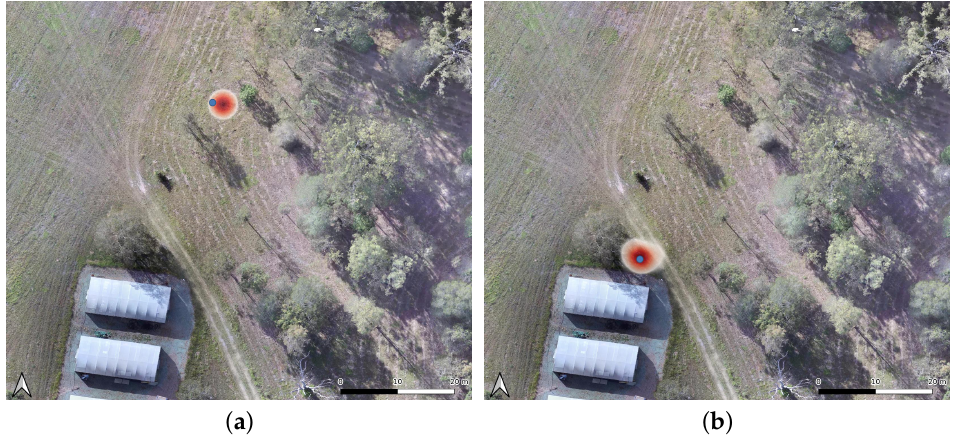
Figure 15. GNSS coordinates’ heatmaps of confirmed victim detections by the POMDP-based motion planner in hybrid flight mode. ( a ) First victim location (blue dot) in an open area. ( b ) Second victim location (blue dot) nearby a